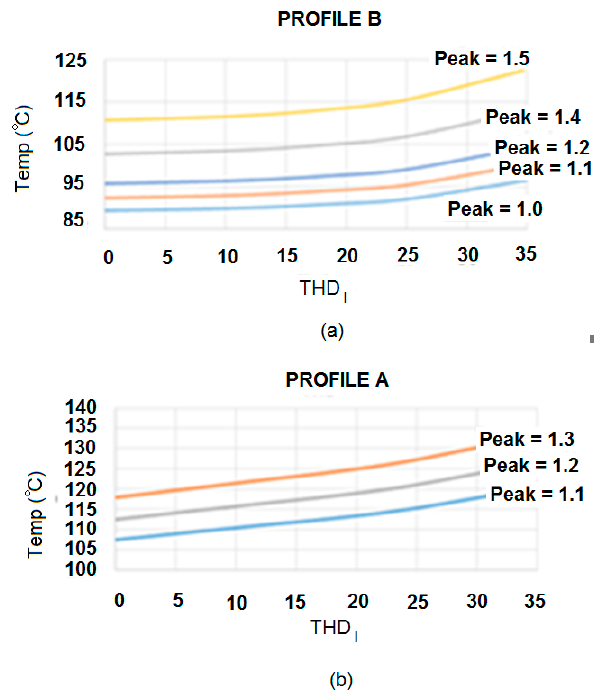
Figure 8. ( a ) Top-oil temperatures induced by Profile B as a function of peak demand and harmonic current distortion. ( b ) Top-oil temperatures induced by Profile A as a function of peak demand and harmonic current distortion.